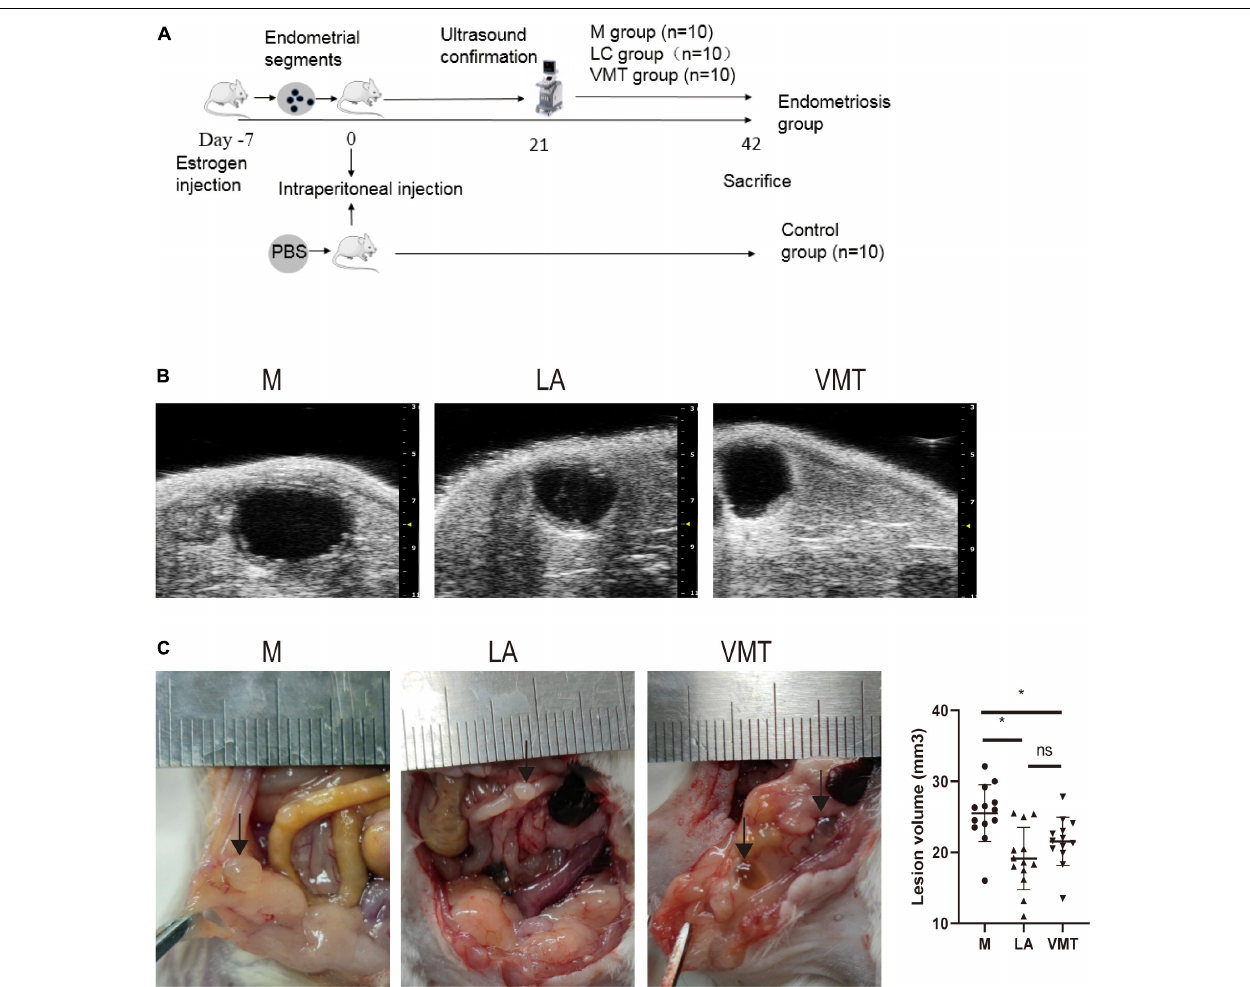
FIGURE 5 | VMT inhibit endometriotic lesion progression. (A) Schematic of experimental timeline and procedures. (B) High-resolution ultrasound confirmed the change in lesion size with treatment. (C) Representative gross images and volumes of ectopic lesions from the indicated treatment groups 3 weeks after established endometriosis confirmed by ultrasound examination. Data are presented as mean ± SE; mock ( n = 10), ABX ( n = 10), and parthenolide ( n = 10). *p < 0.05 and ns,